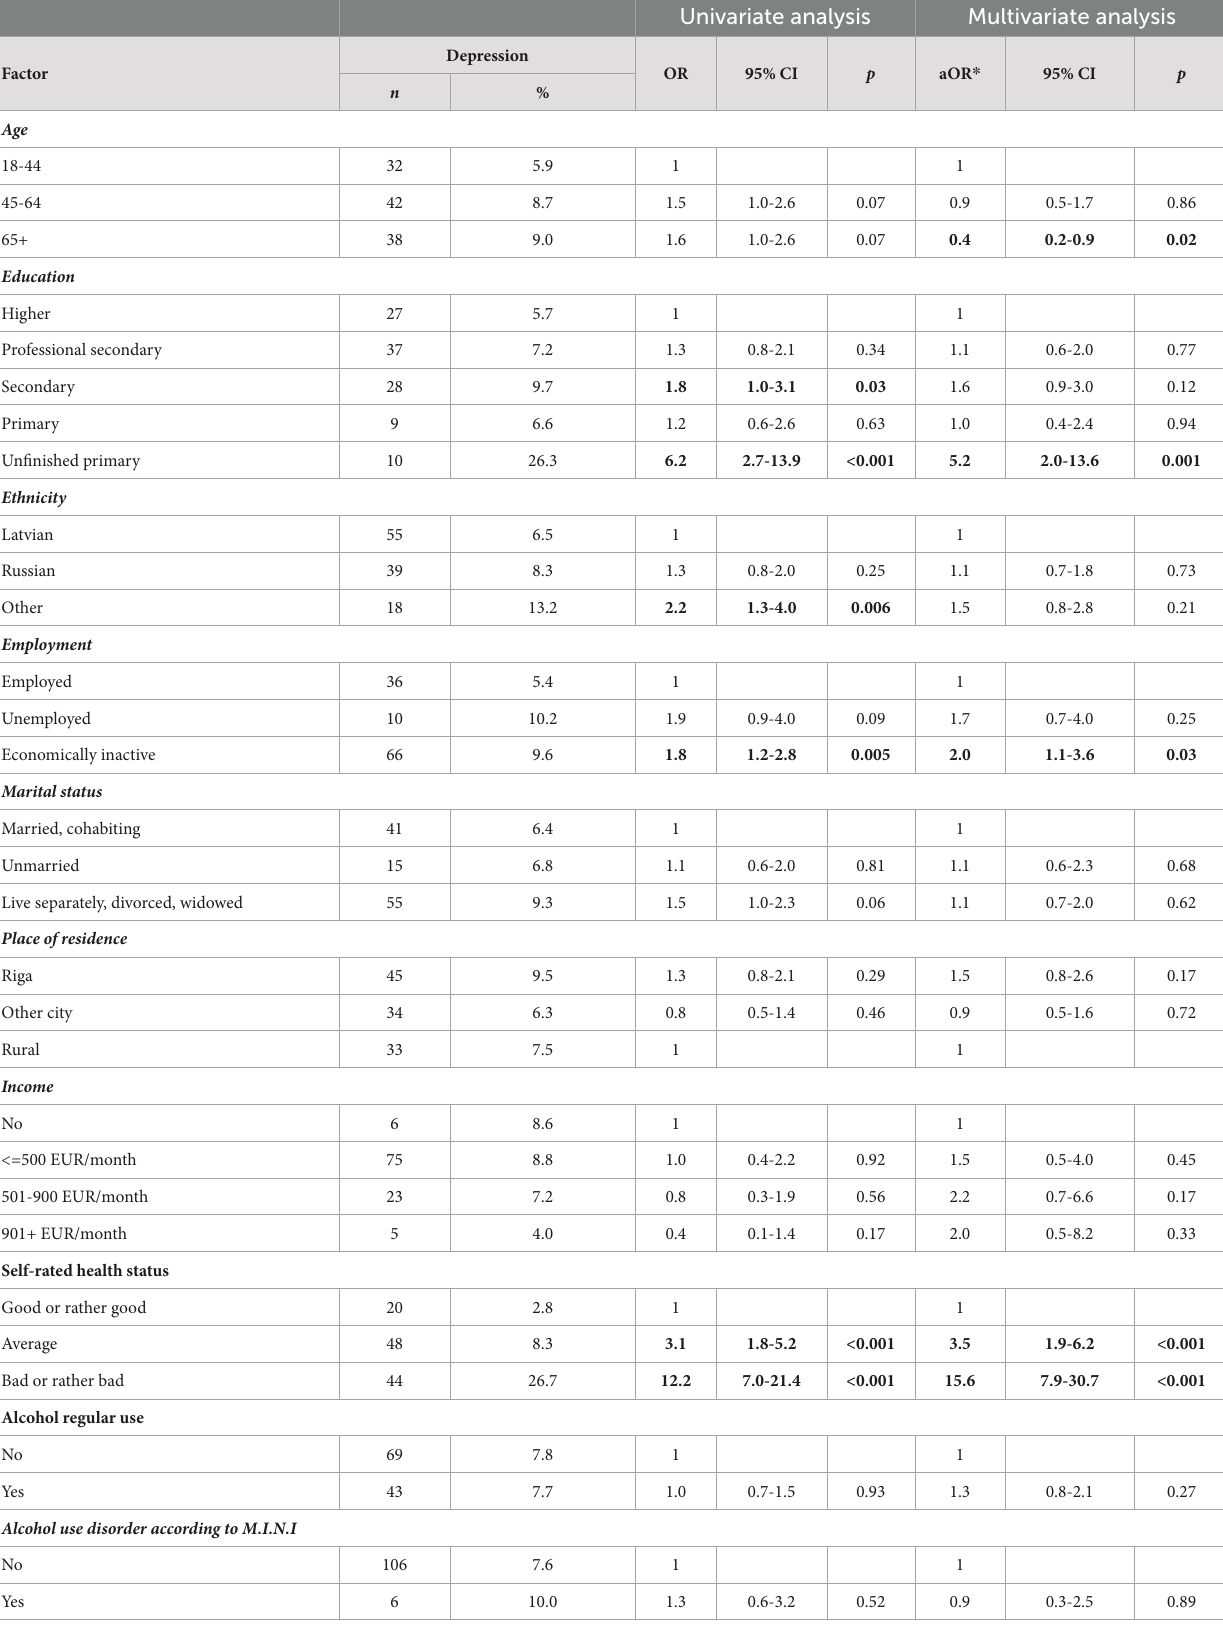
TABLE 3 Prevalence of depression in females, results of univariate and multivariate logistic regression analysis. Univariate analysis Multivariate